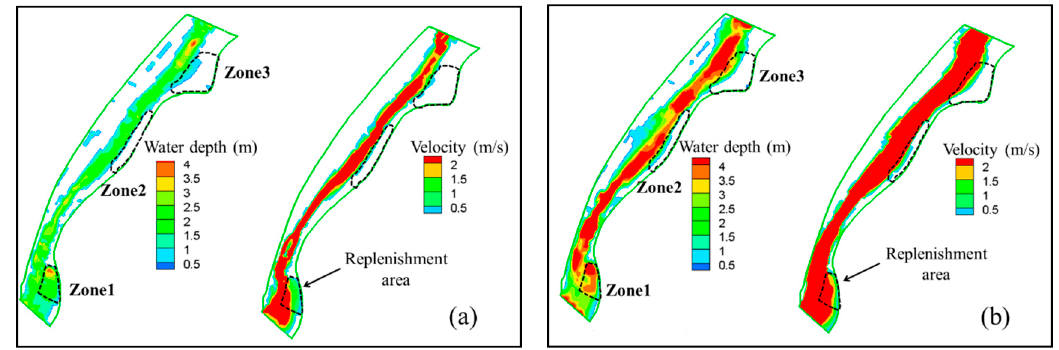
( b ) 6100 m 3 / Figure 7. Simulated water depth and flow velocity distributions at flood discharges of ( a ) 1700 and ( b ) 6100 m 3 /s.